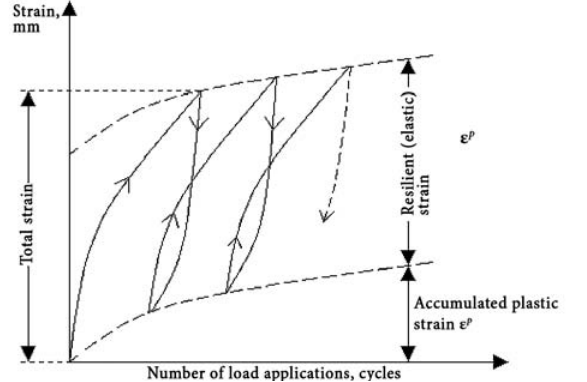
Fig. 1 . Typical resilient response from repeated load applications (Park